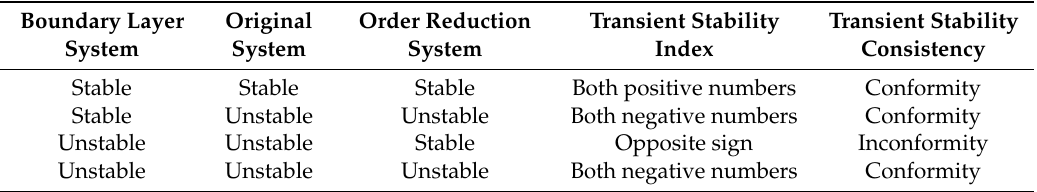
Table 1. Transient state stability laws of order reduction before and after